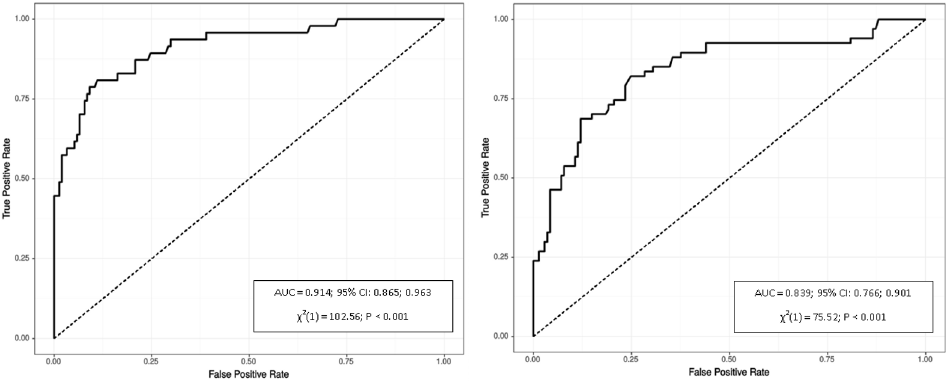
Fig 1. Receiveroperating characteristics of VAT for identifying waist circumference (cid:21) 94 cm in males (left) and (cid:21) 80 cm in females (right). P refers to logistic regression model.